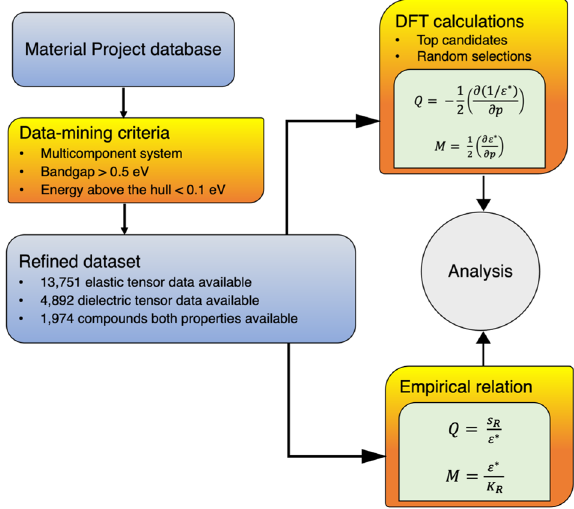
Fig. 1 Flow chart showing data curating and fi rst-principles computation on data-mined compounds. Data-mining Materials Project database and DFT computation work fl ow for search of high electrostriction